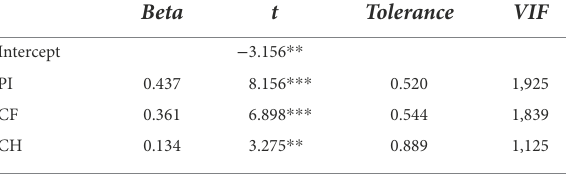
TABLE 2 Multicollinearity